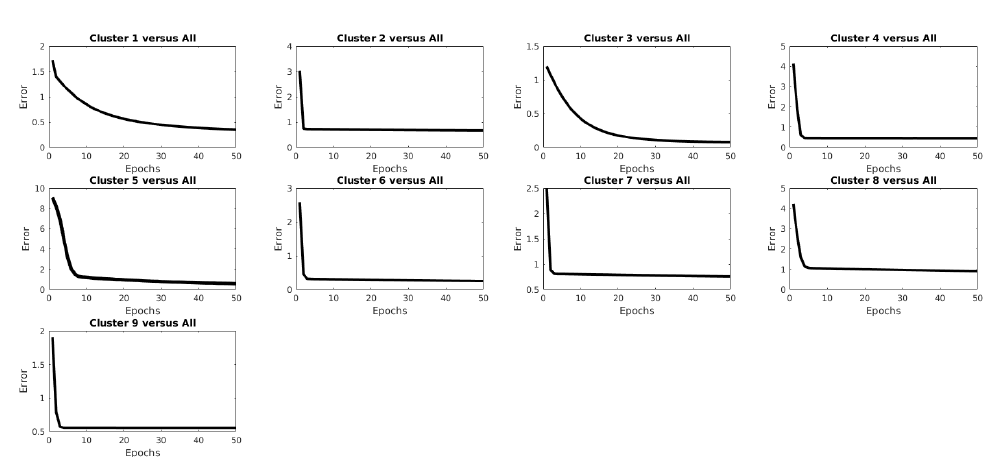
Figure 9. Error versus epoch curve of each one-versus-all case for the Pavia University image. Only the first 50 training epochs are shown here.